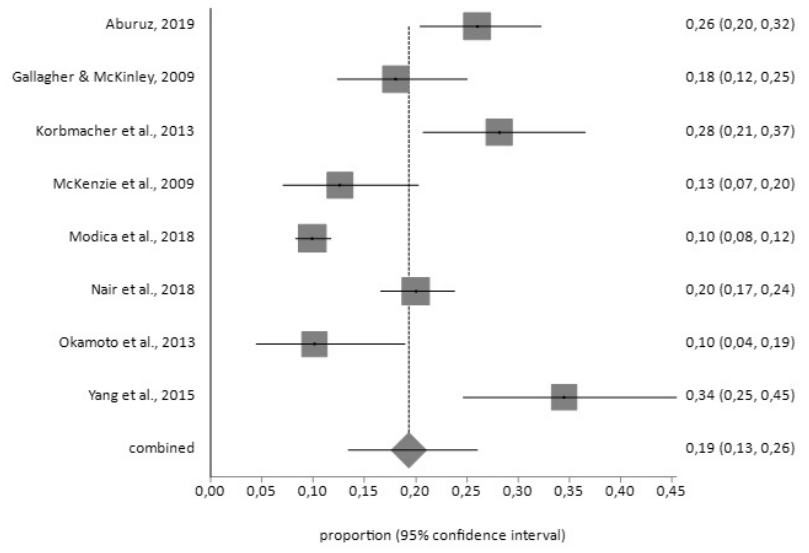
Figure 3. Forest plot for post-CABG depression using HADS.